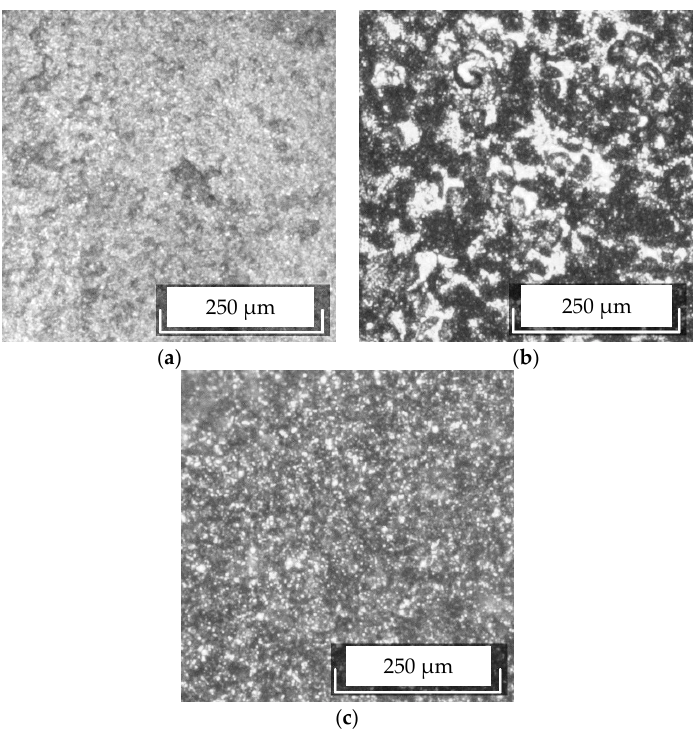
Figure 8. Specimen surface morphology: ( a ) CPC No. 1 (NaCl–KCl–NaF (10 wt %)–K 2 NbF 7 (8 wt %), i = 5 × 10 − 3 A · cm − 2 , τ = 8 h, t = 750 ◦ C); ( b ) CPC No. 2 (the same melt, i = 1 × 10 − 2 A · cm − 2 , τ = 8 h, t = 750 ◦ C); and ( c ) CPC No. 3 (the same melt, i = 2 × 10 − 2 A cm − 2 , τ = 10 h, t = 750 ◦